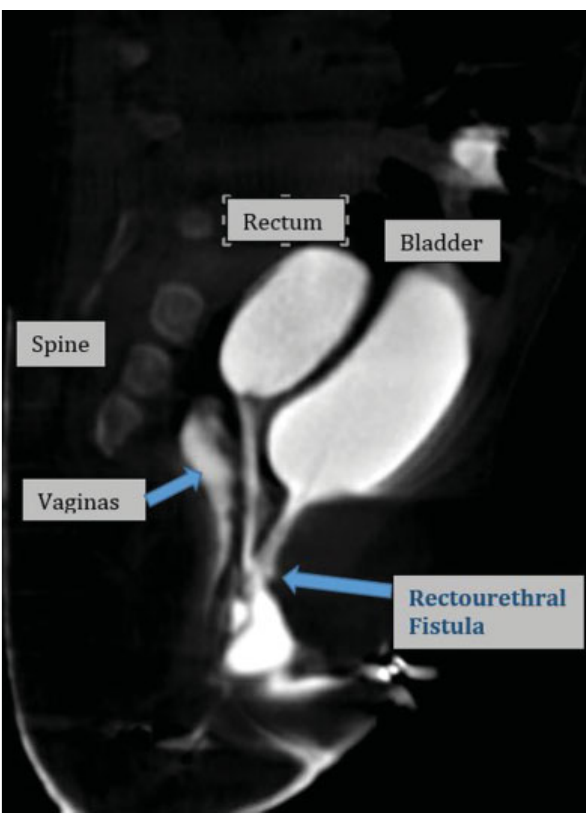
Fig. 1 Rectal fi stula inserting in the posterior urethra.